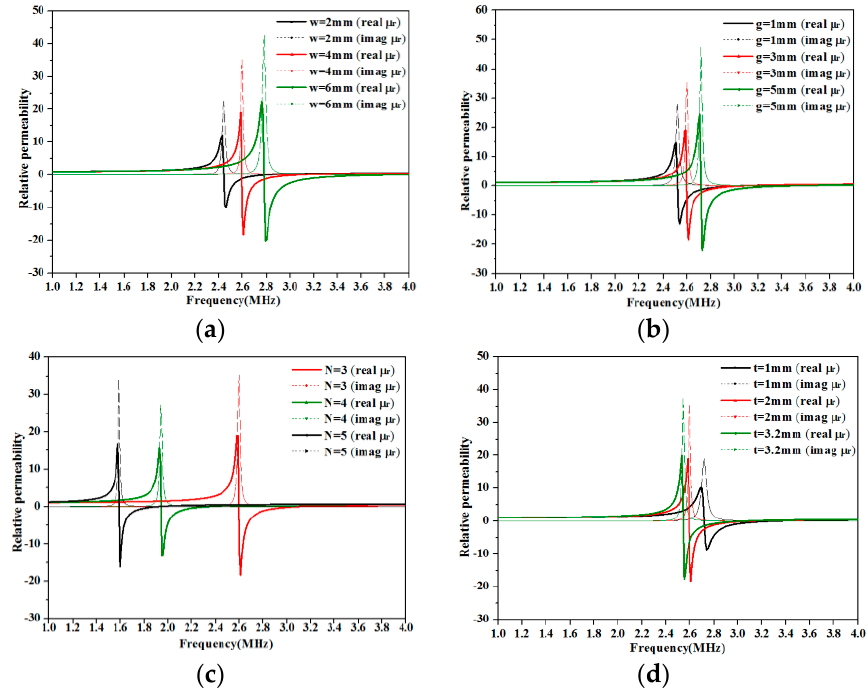
Figure 8. The relative permeability as a function of the resonance frequency of the MM unit cell by varying: ( a ) The width of the copper strip; ( b ) the interval between the copper strips; ( c ) the turn number of the copper strip; and ( d ) the thickness of the substrate.